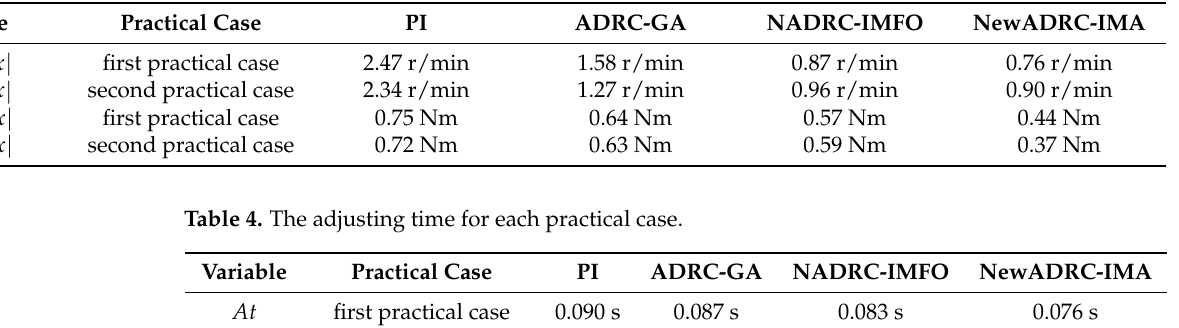
Table 3. The maximum absolute value of stable control speed and torque error for each practical case.